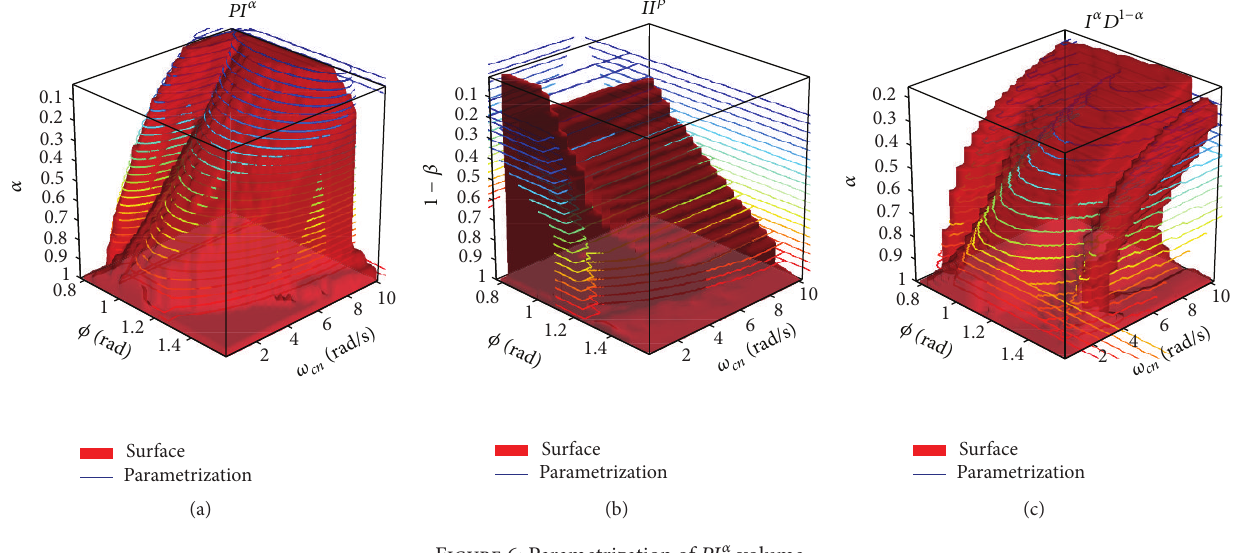
Figure 6: Parametrization of 𝑃𝐼 𝛼 volume.